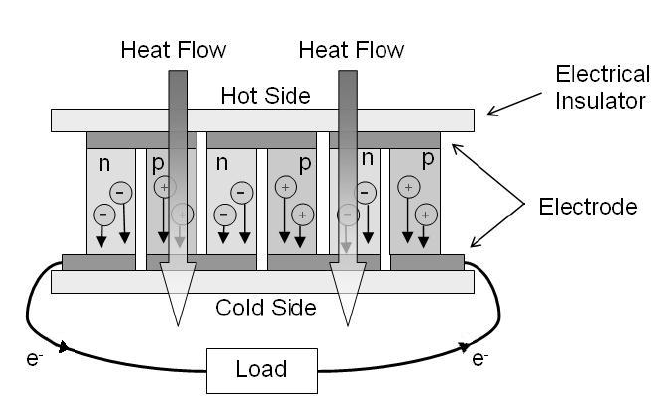
Figure 11 . Thermoelectric